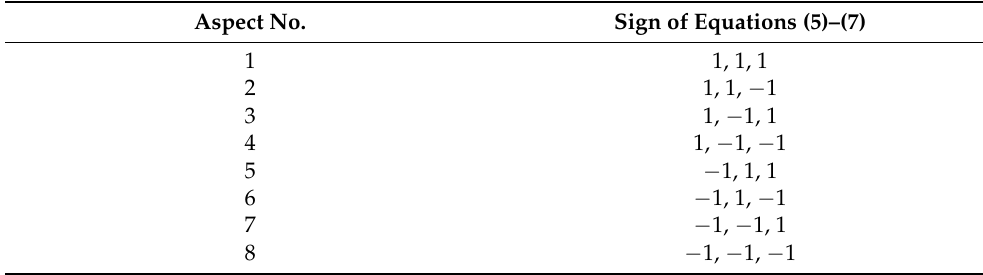
Table 1. Rules for determining the aspects. Aspect No. Sign of Equations